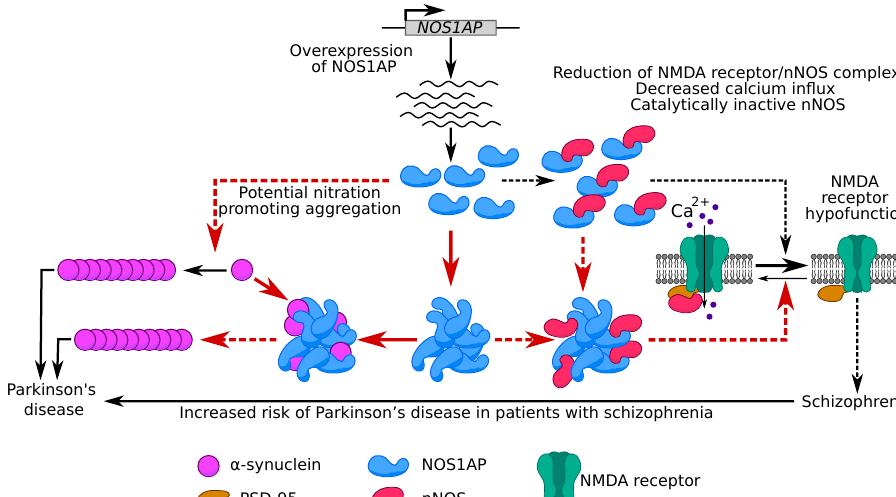
Figure 6. Possible roles of NOS1AP aggregation in pathogenesis of Parkinson’s disease and schizophrenia. Solid lines correspond to experimental results and dashed lines mark hypotheti- cal connections. The red arrows indicate the processes and the hypotheses that we put forward based on our